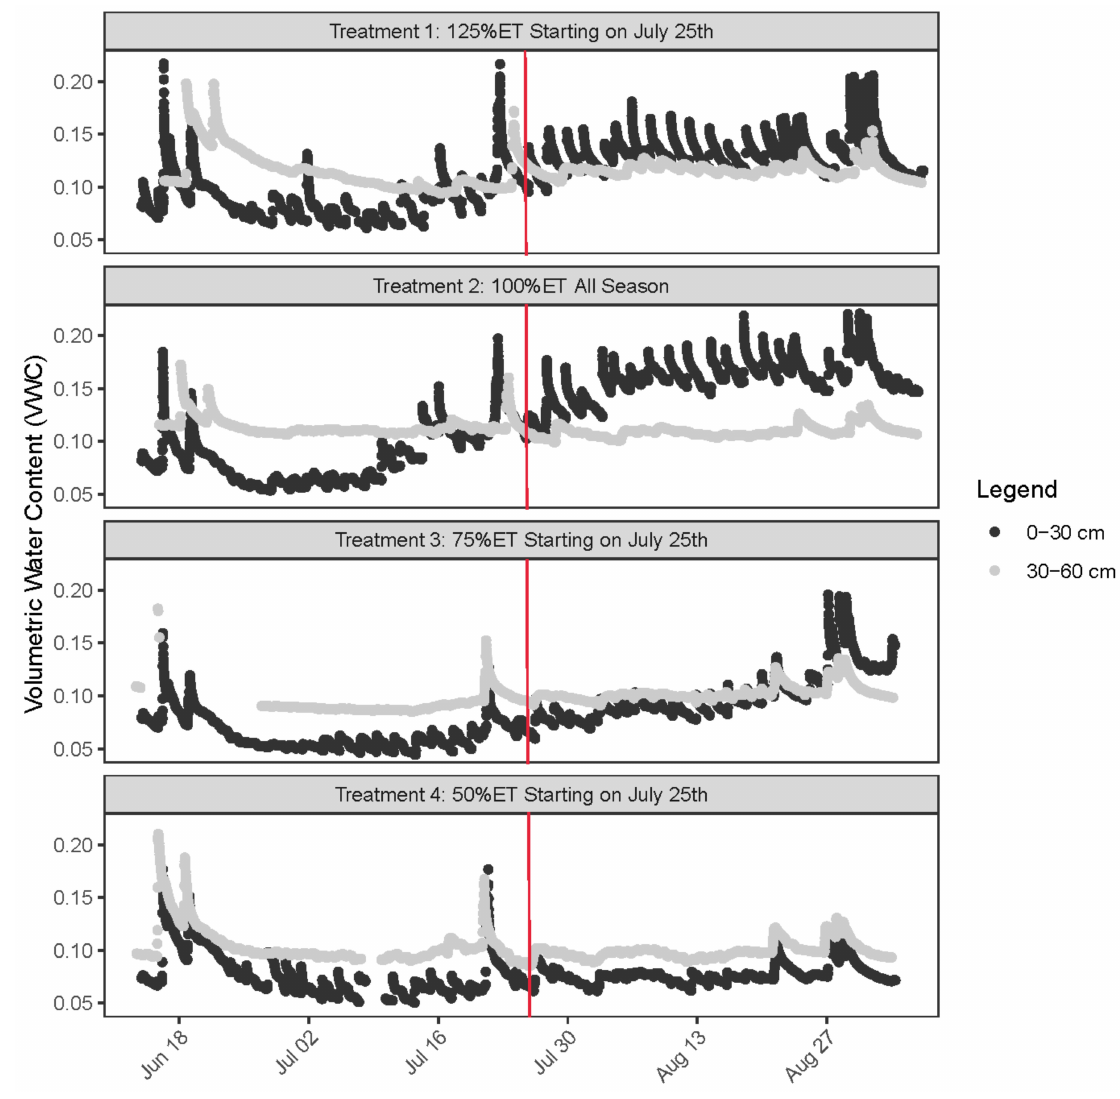
Figure 3. Volumetric water content (VWC) data from 2018. The black line indicated VWC at 0–30 cm soil depth, and the grey line indicated VWC at 30–60 cm soil depth. Start of the irrigation treatment, which was on 25 July, was marked by a red line. Gaps in the graphs were due to equipment